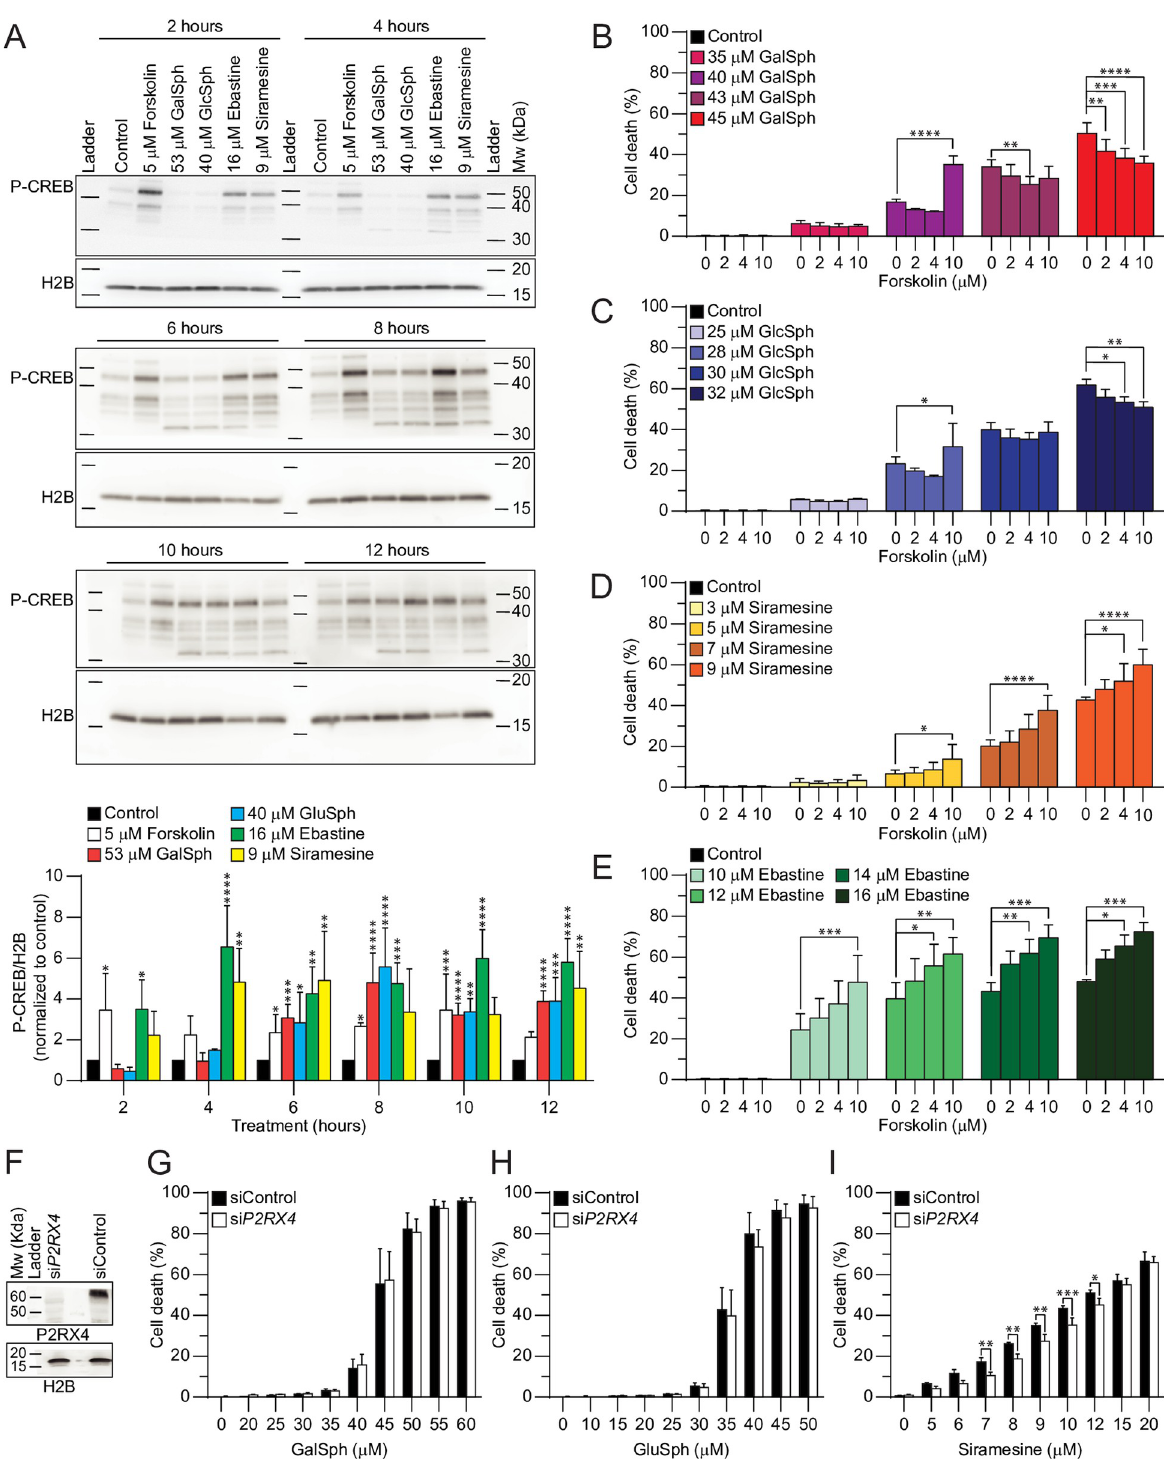
Fig 5. GalSph and GlcSph increase cAMP levels in MCF7 cells. (A) Representative Western blots of P-CREB and histone H2B (loading control) in lysates of MCF7 cells treated as indicated ( three top panels ), and densitometric quantification of P-CREB/H2B ratios normalized to untreated control samples ( bottom ). (B-E) Death of MCF7 cells treated with indicated concentrations of GalSph (B), GlcSph (C), siramesine (D, positive control), or ebastine (E, positive control) for 48 hours was determined as in Fig 1A. When indicated, 2–10 μ M forskolin was added 1 hour before the addition of lysosphingolipids or CADs. (F) Representative Western blots of P2RX4 and histone H2B (loading control) in lysates of MCF7 cells